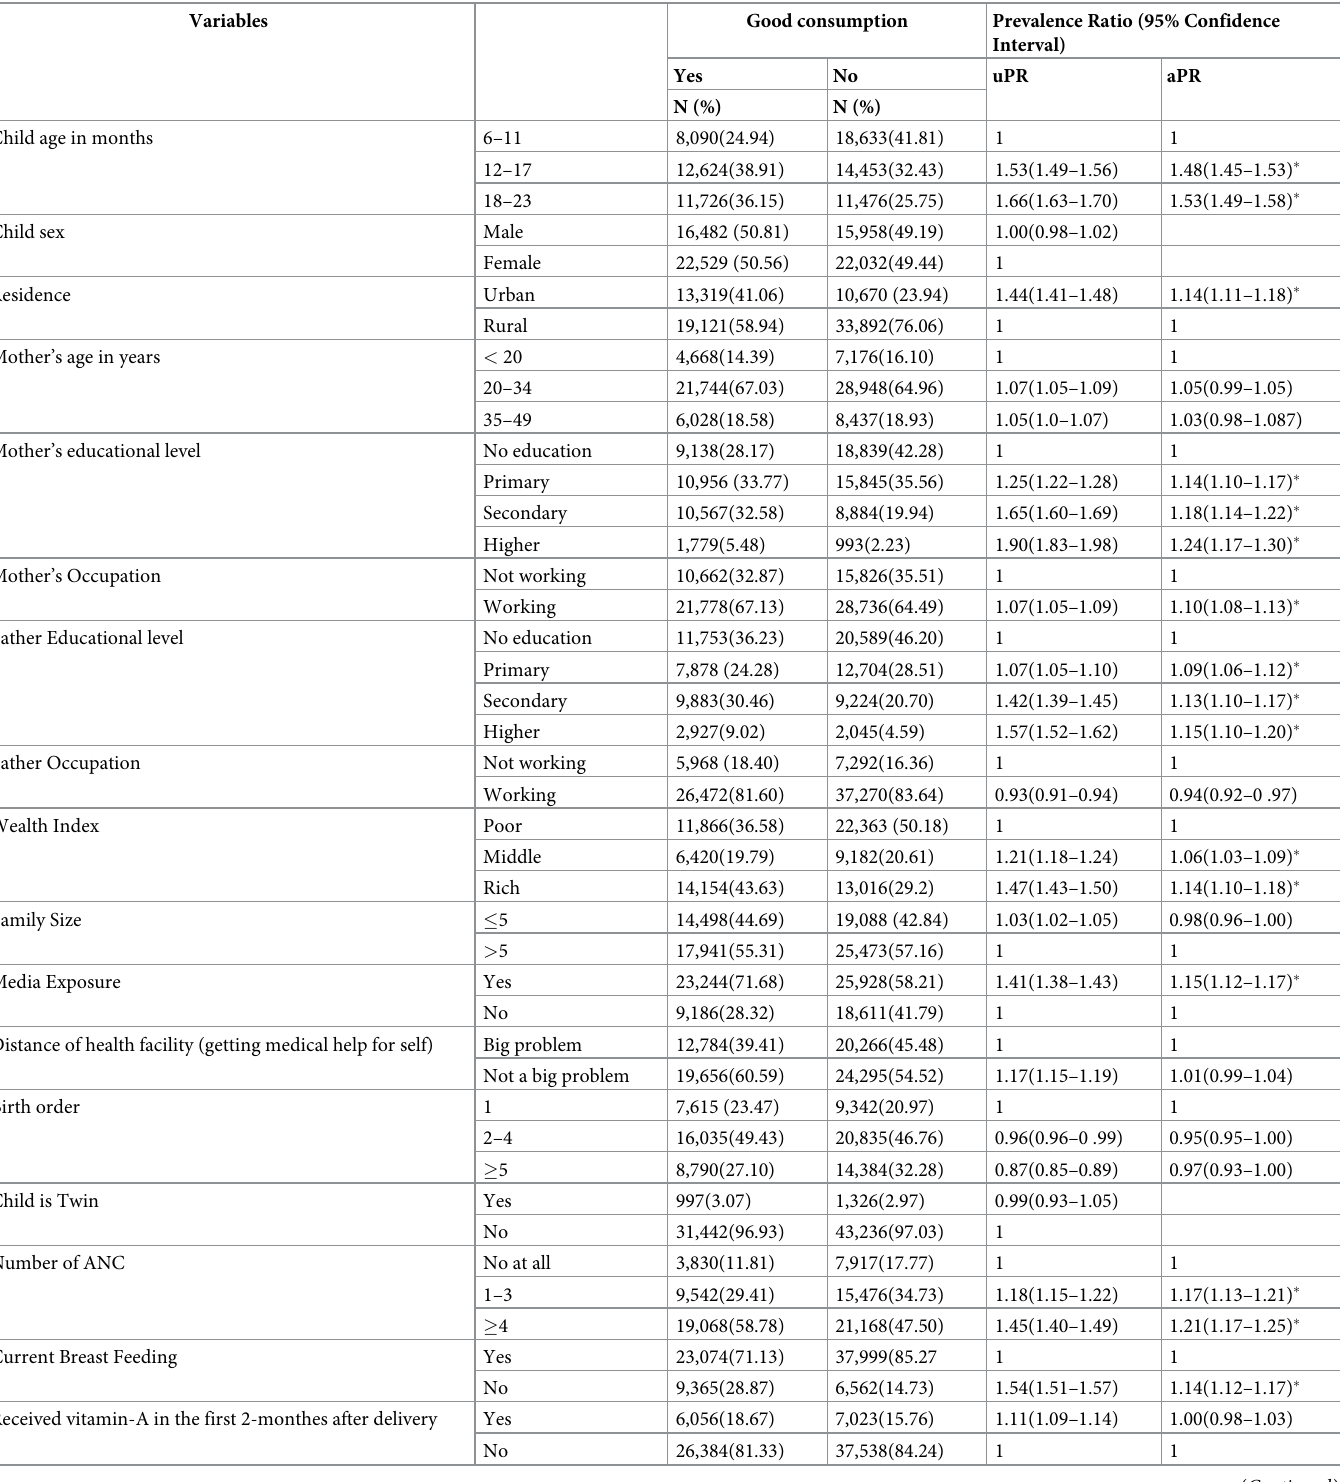
Table 4. Multilevel Poisson regression analyses of good consumption of iron in sub-Saharan Africa (n = 77,001).